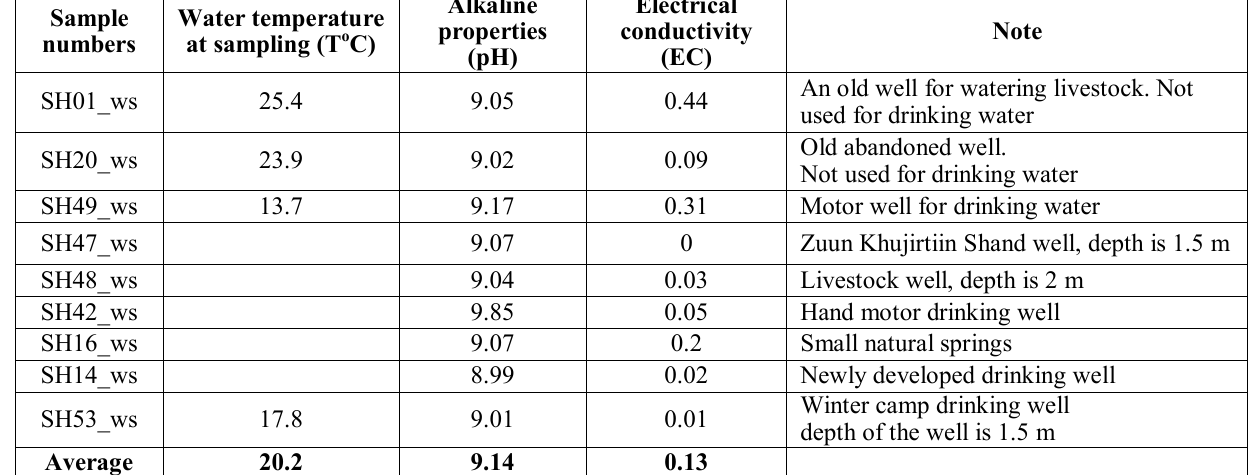
Table 2. General characteristics of river water in Shuteen area, 2016